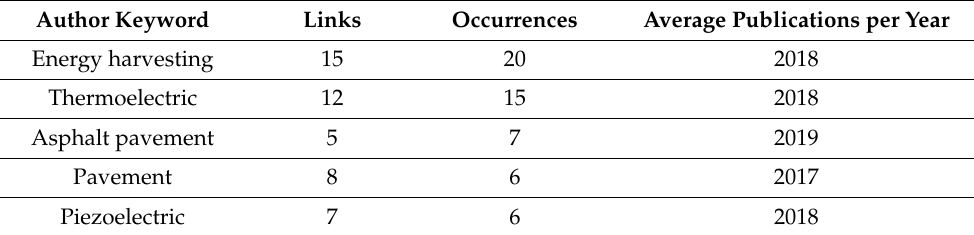
Table 3. Top Six Author Keywords